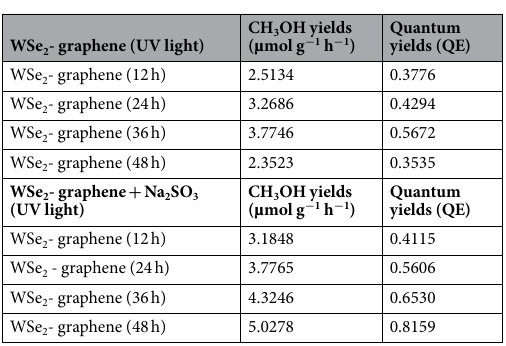
Table 2. Effect of preparation method on methanol yields and quantum yields under Uv